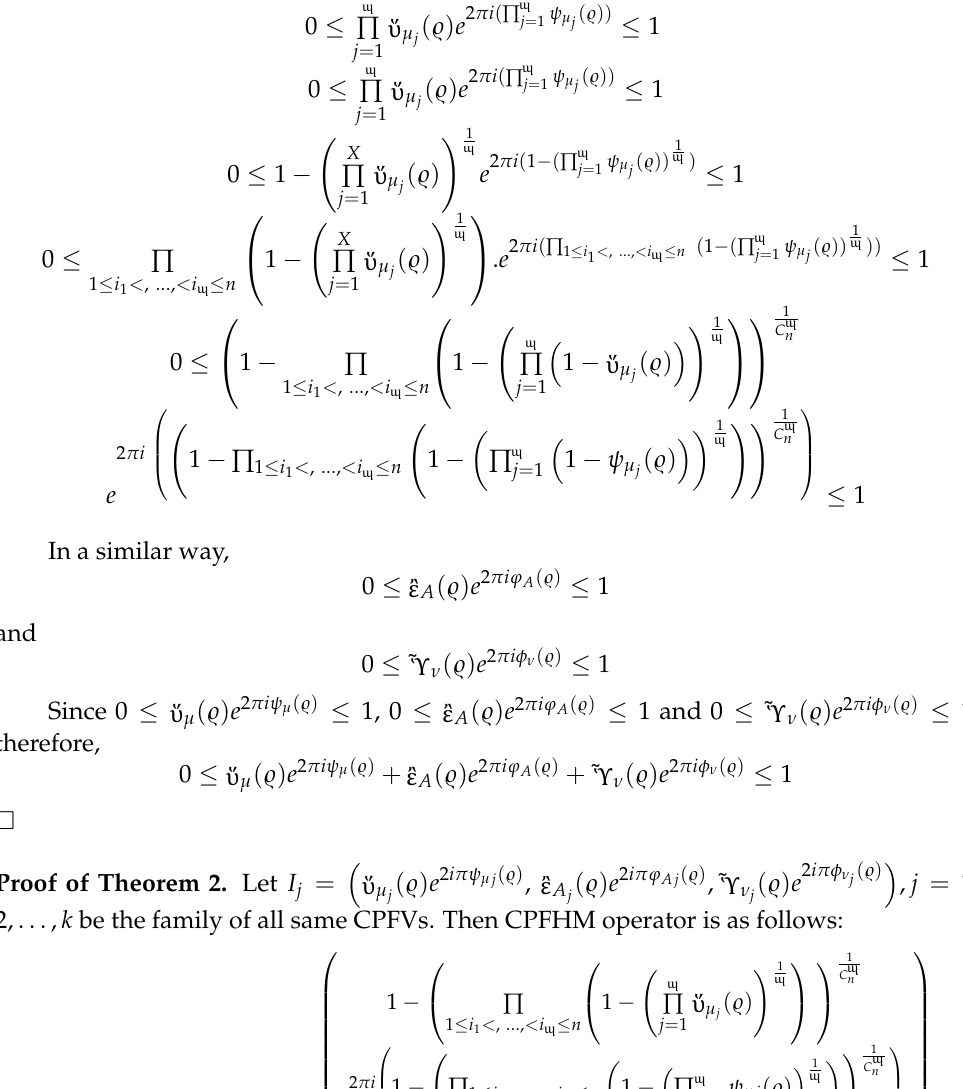
Table 1. Symbols and their meanings.